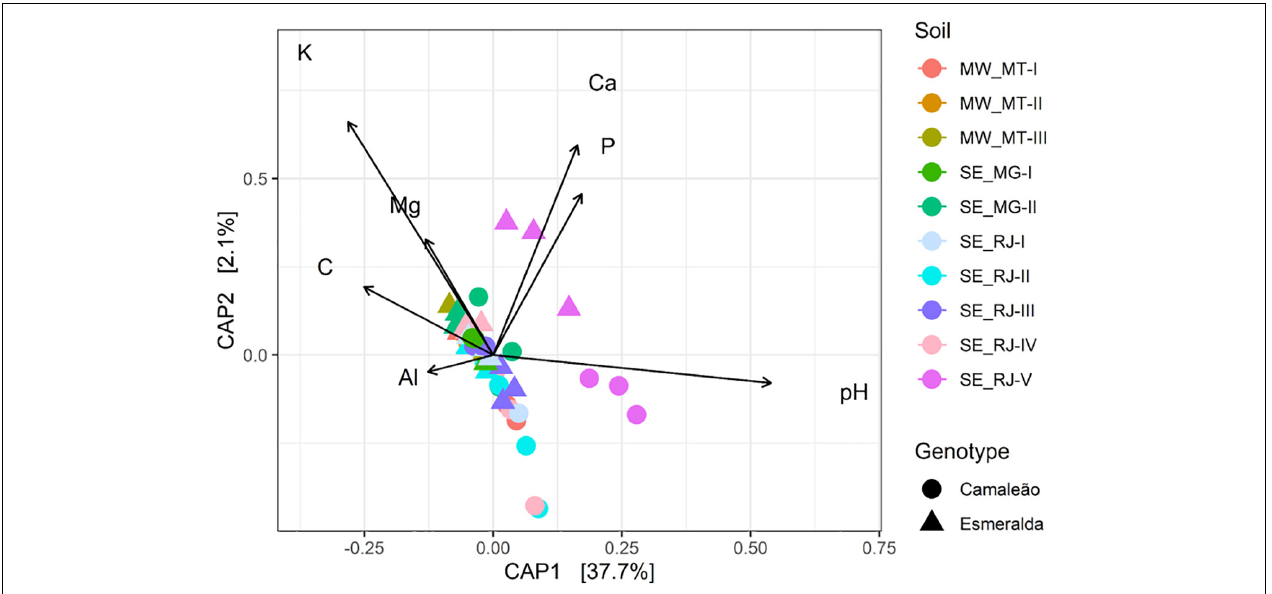
FIGURE 6 | Canonical analysis of principal coordinates (CAP) of Bray-Curtis distances and the Permutational ANOVA between nodule bacterial communities (10 soil samples × 2 mung bean genotypes) estimated by 16S rRNA gene sequencing and the chemical data of soil samples presented in Table 1 : pH, Al 3 + (aluminum), Ca 2 + (calcium), Mg 2 + (magnesium), P (phosphorus), K + (potassium), and C